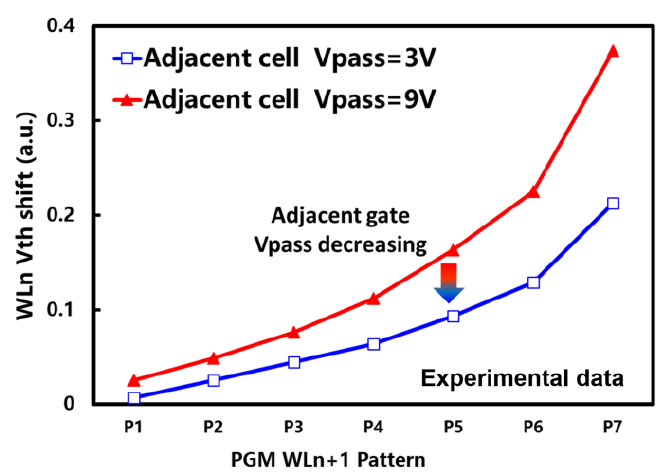
Figure 5. Comparison of different WLn + 1 (aggressor) patterns in regard to the decrease in the adjacent cell Vpass during programming to improve z-interference. P1 to P7 on the horizontal axis refer to different states in the TLC mode, which does not include the erase state.